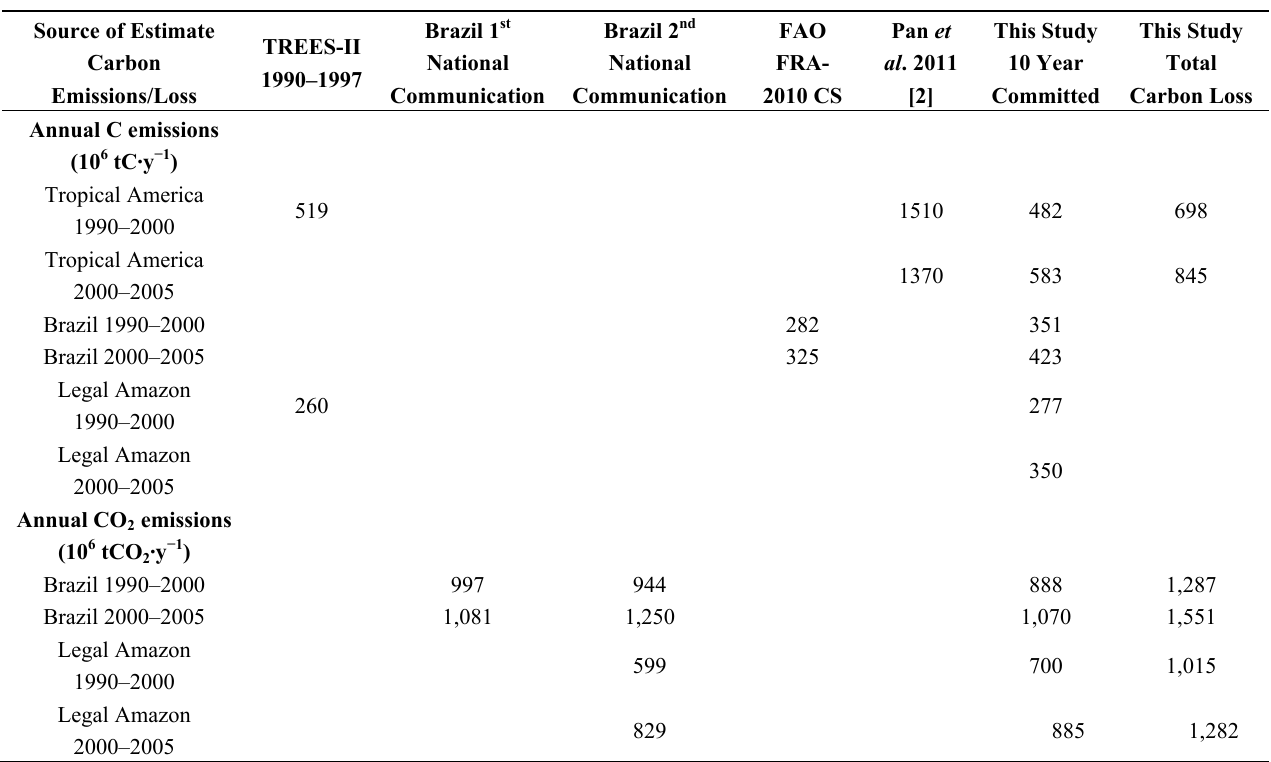
Table 5. Annual carbon emissions from tropical forest cover changes for periods 1990–2000 and 2000–2005 for (i) South & Central America region; (ii) Brazil; (iii) Brazilian Amazon from different sources—from oldest to most recent publication date (in 10 6 ty − 1